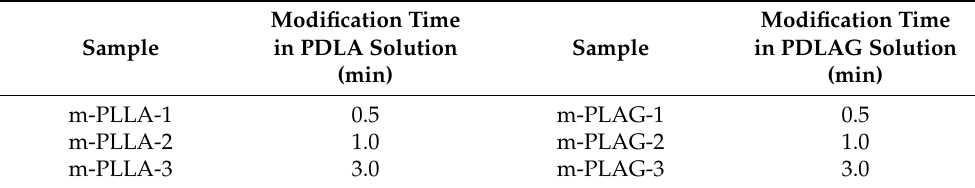
Table 1. Modification time of PLLA films modified by PDLA and